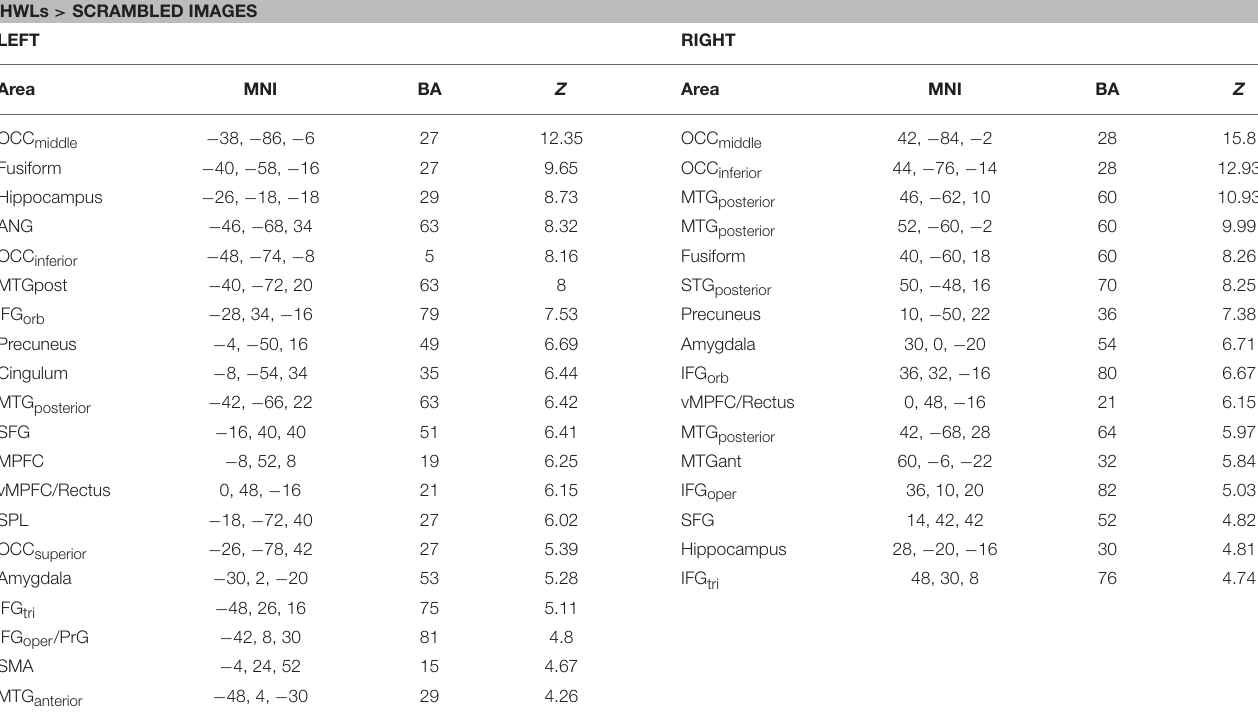
TABLE 1 | Brain areas showing increased activation during viewing of health warning labels vs. scrambled images. HWLs > SCRAMBLED IMAGES